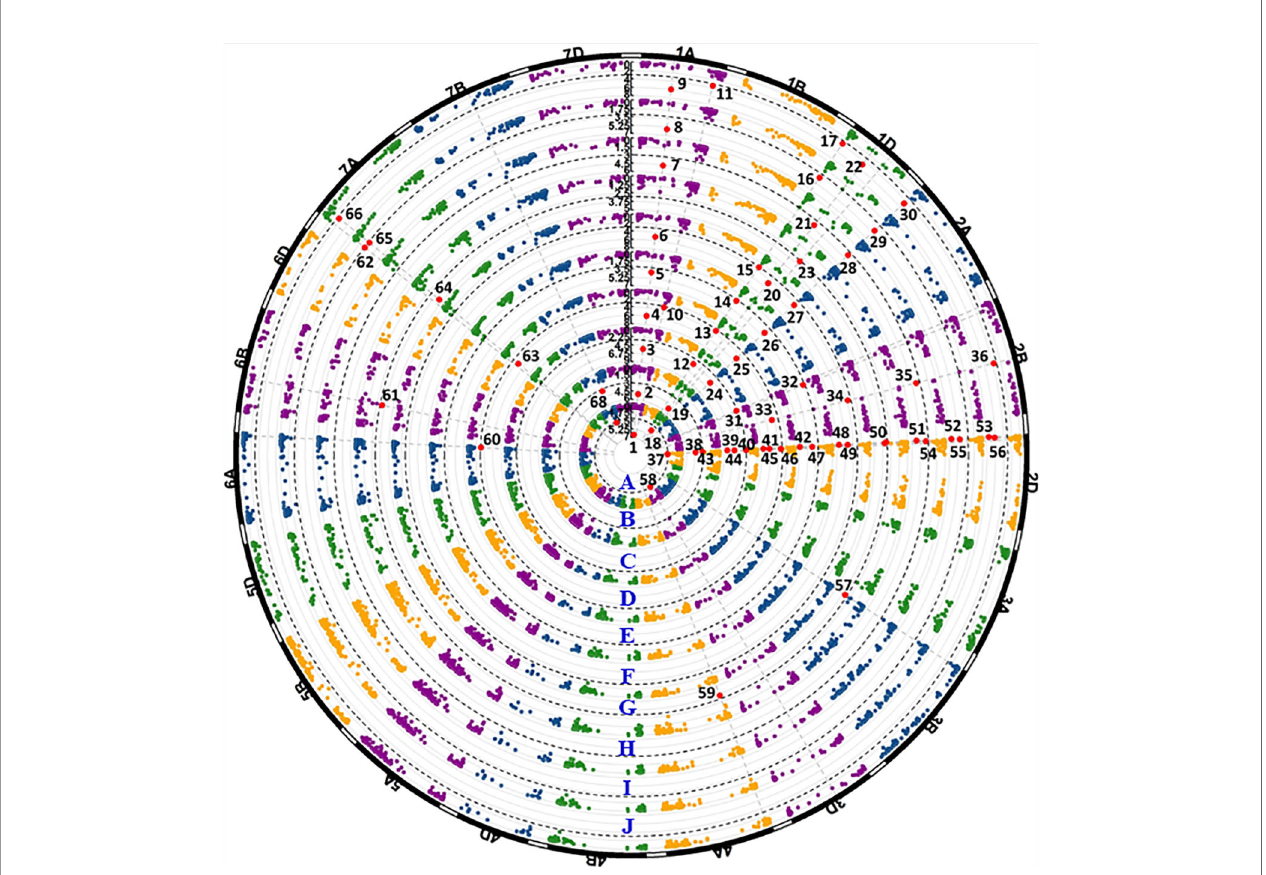
FIGURE 5 | Manhattan plots of signi fi cant p values for markers associated with stripe rust resistance detected in the fi eld experiments. The black dash lines show the threshold -log10(p) value of 3. Each circular represents one fi eld data set of Pullman 2018 IT data (A) , Pullman 2018 DS data (B) , Mount Vernon 2018 IT data (C) , Mount Vernon 2018 DS data (D) , Pullman 2019 IT data (E) , Pullman 2019 DS data (F) , Mount Vernon 2019 IT data (G) , Mount Vernon 2019 DS data (H) , BLUE-ALL-IT data (I) , and BLUE-ALL-DS data (J) . Signi fi cant markers are enlarged in red dots and